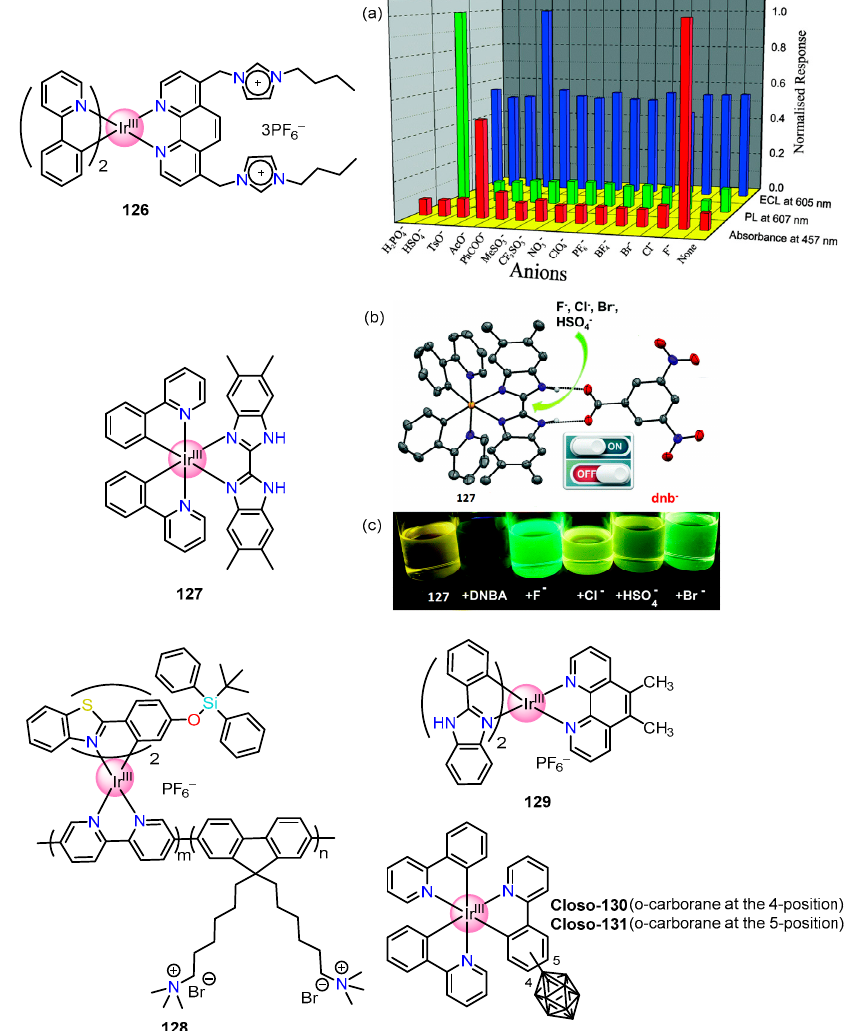
Figure 17. Structures of Ir(III) complexes 126 – 131 ; ( a )The comparative response of complex 126 in UV − Vis, PL, and ECL upon the addition of anions. [Adapted from reference [129]; Copyright © 2023, Royal Society of Chemistry] . ( b ) luminescent on/off sensor for anions; ( c ) picture of 127 in chloroform and excess anions. [adapted from reference [130]; Copyright © 2023, Royal Society of Chemistry] .